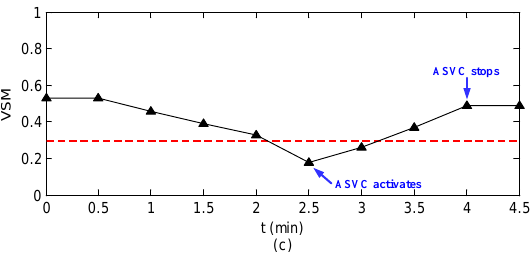
V ;( b ) The trace of V ; ( c ) The trace of VSM. 24 29